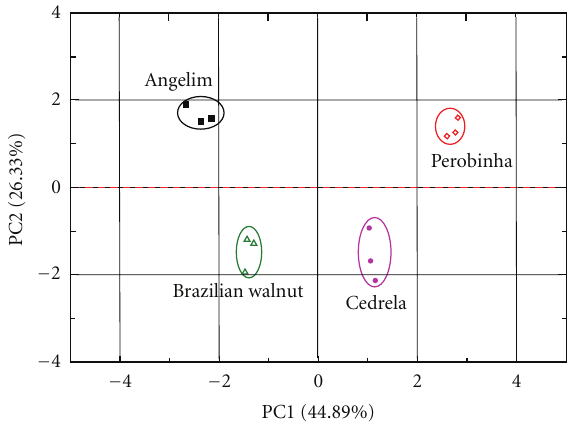
Figure 6: Bidimensional principal component analysis of the four wood species by LIBS.